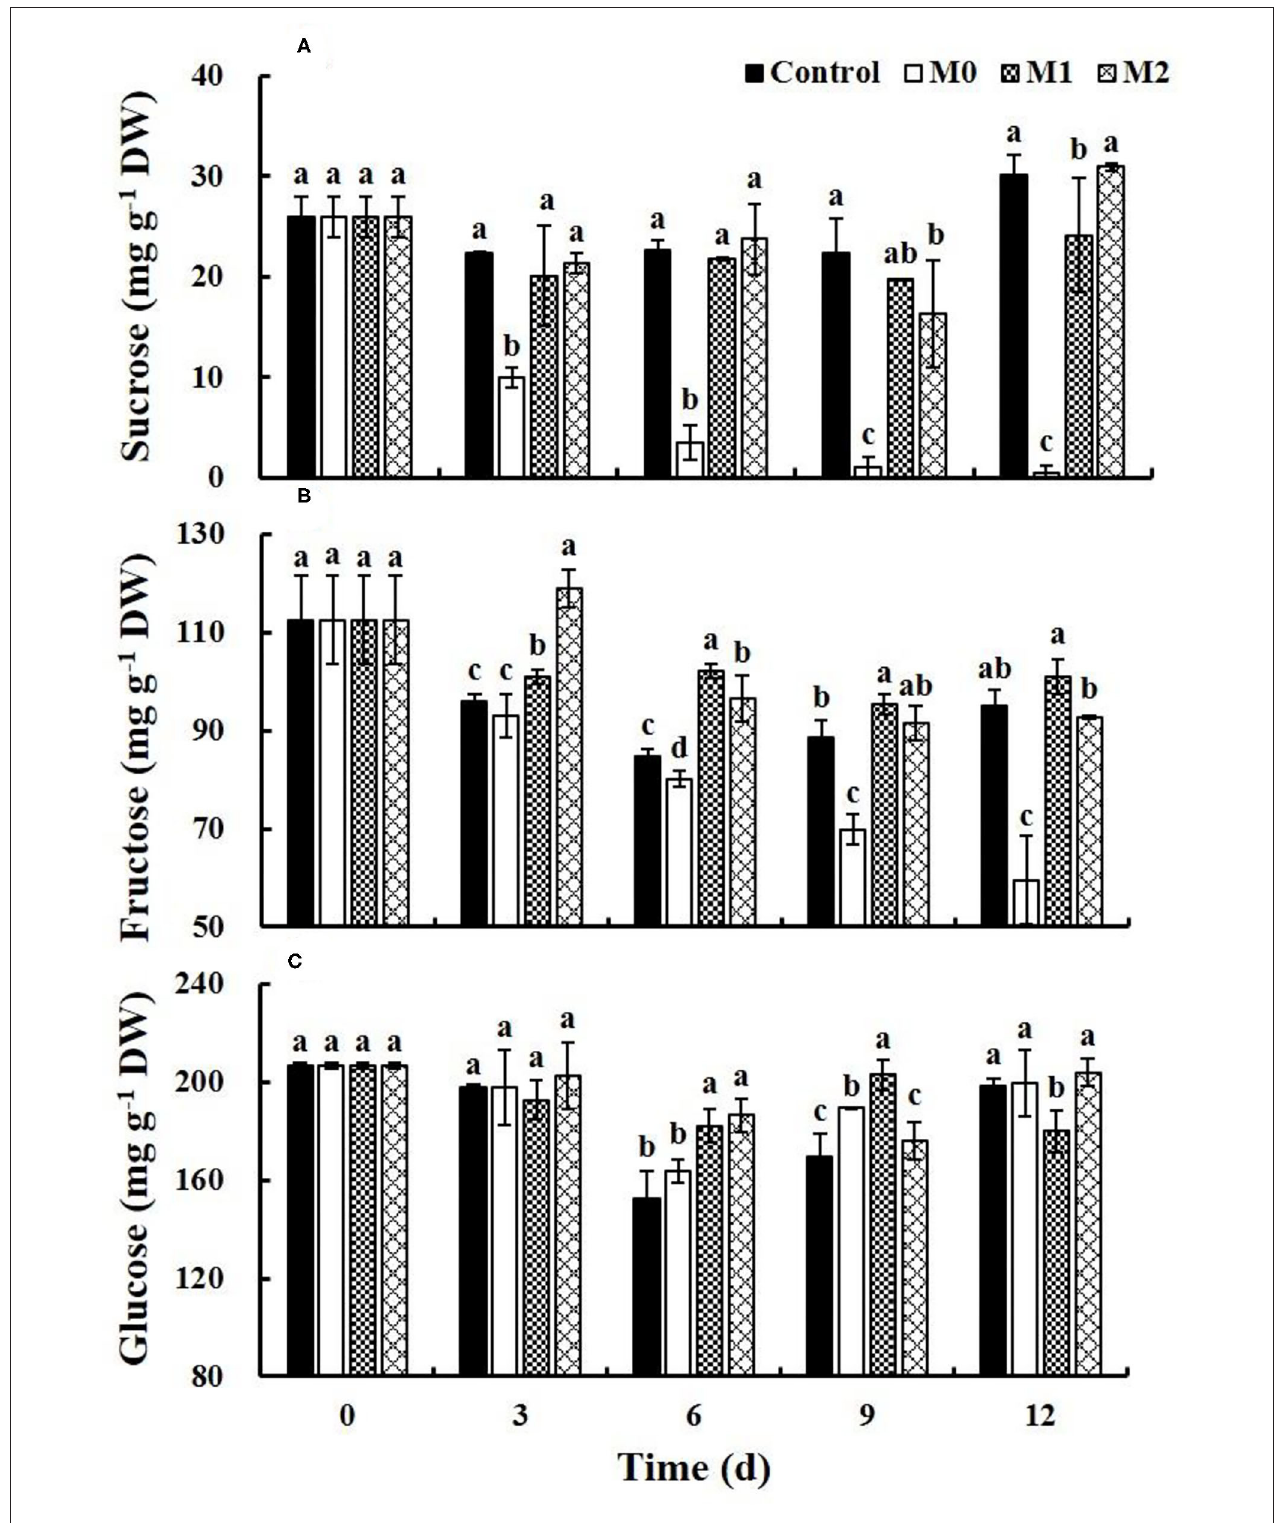
FIGURE 3 | Content of sucrose (A) , fructose (B) , and glucose (C) of different baby mustard lateral buds during storage at 4 ◦ C under different MAP treatments. Different letters in the figure indicate statistically significant differences among treatments for each storage day ( P < 0.05). M0 indicates packaging with no holes; M1 indicates packaging with 6mm in diameter holes; M2 indicates packaging with 12mm in diameter